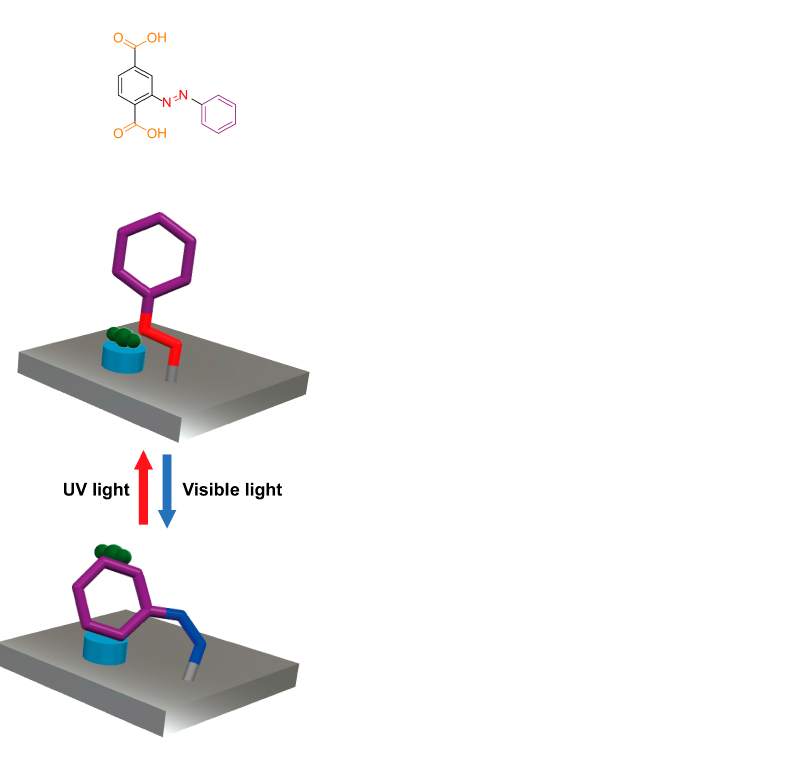
Figure 3. ( a ) Chemical structure of the azobenzene ligand 1 ; ( b ) cartoon representation of the oper- ation of the azobenzene-functionalized UiO-66 composite as efficient adsorbent for tailorable CO 2 adsorption [62]. Color key: metallic grey = azobenzene-functionalized UiO-66 ( U-azo ); red = nitrogen atoms of the trans isomer; dark blue = nitrogen atoms of the cis isomer; purple = phenyl ring; dark green = CO 2 molecule; white = hydrogen atoms; light blue = TEPA